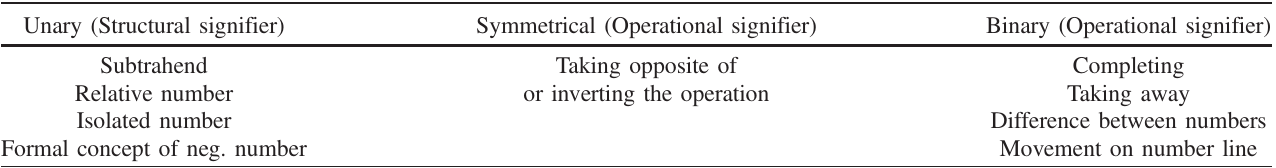
TABLE I. A map of the different uses of the negative sign in elementary algebra, reproduced from Vlassis [11]. Unary (Structural signifier) Symmetrical (Operational signifier) Binary (Operational signifier) Subtrahend Taking opposite of Completing Relative number or inverting the operation Taking away Isolated number Difference between numbers Formal concept of neg.